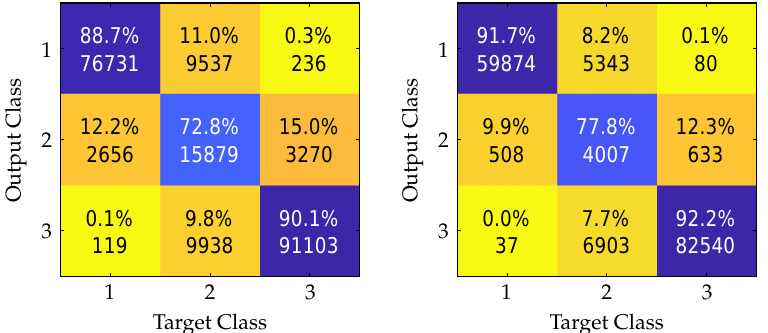
Figure 5. Confusion matrices without T-scaling ( left ) and with T-scaling ( right ) with the precision